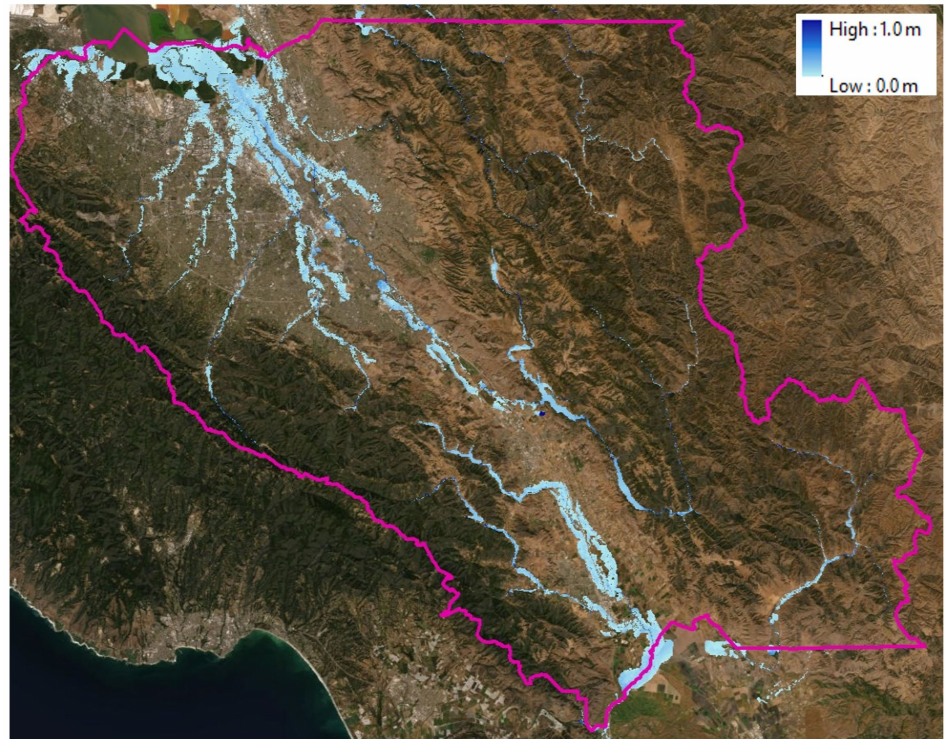
Figure 10. 100 yr flood hazard map for Santa Clara County based on HAZUS flood